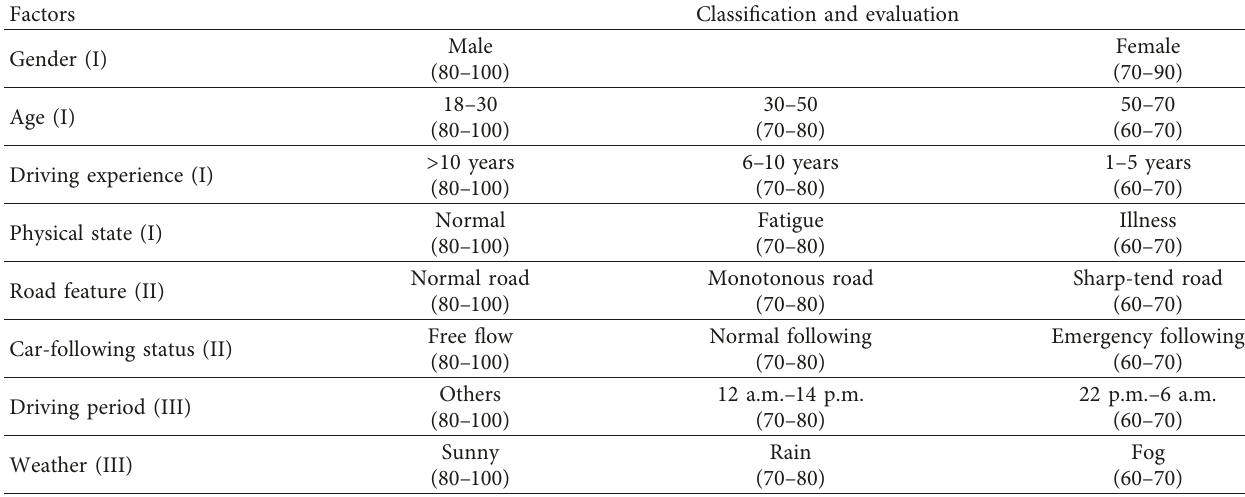
Table 1: Evaluation and classification of different influencing factors.